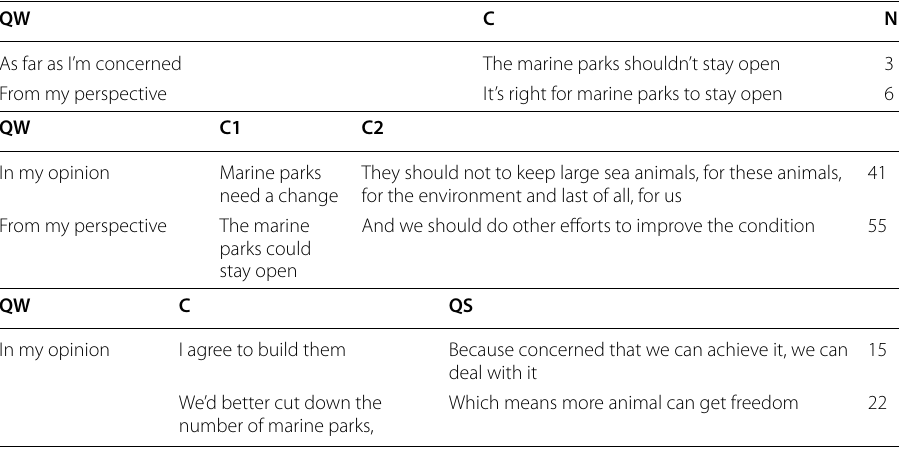
Table 10 Examples of argument types corresponding to higher score compositions QW C